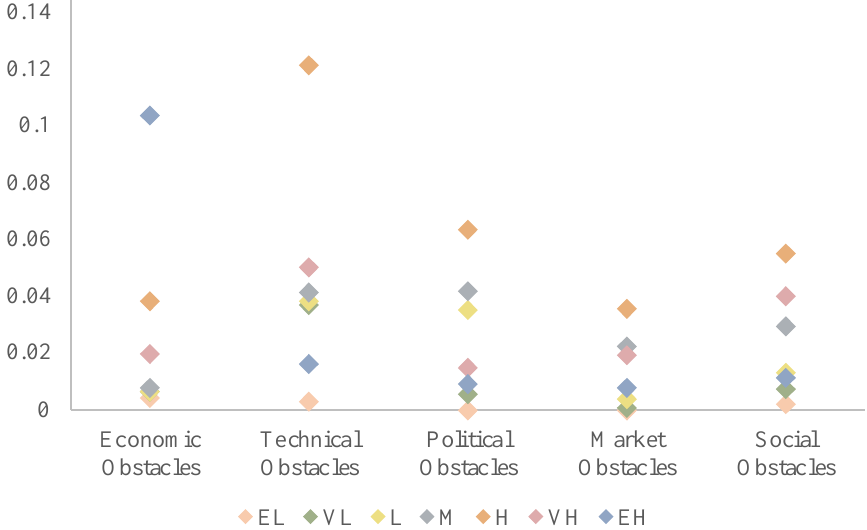
Table 6. The membership degree of five categories of obstacles.